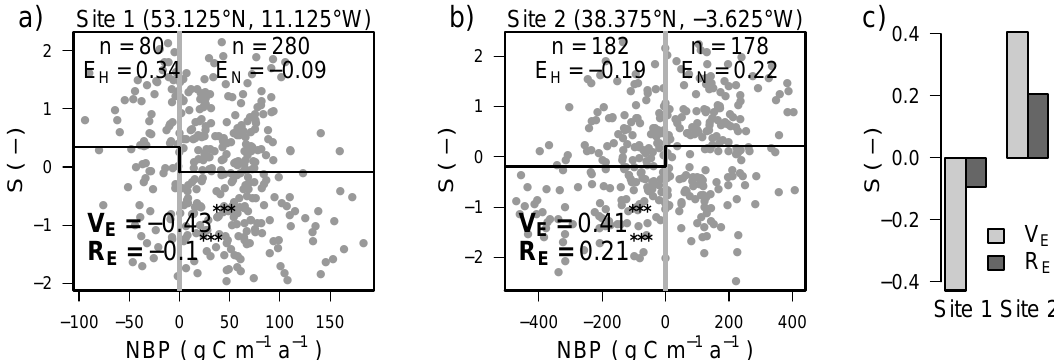
Figure 2. Scatterplots of sys variable NBP (gCm − 2 a − 1 ) against env variable SPEI (dimensionless) with monthly values from 1981 to 2010 for 2 sample grid cells in Europe: (a) northern Germany (53.125 ◦ N, 11.125 ◦ W) and (b) Spain (38.375 ◦ N, 3.625 ◦ E). Vertical lines denote the threshold value for the hazard and horizontal lines the expectation values for the respective env variable in the hazard ( E H ) and the non-hazard case ( E N ). Resulting expectation values, V E and the frequency of data points in both groups are given (dimensionless numbers). Significance level of the Welch t test between both groups is indicated for V E . (c) Calculated V E and R E values with negative sign for site 1 (vulnerable to wet conditions) and positive for site 2 (vulnerable to drought). Site 1 (53.125°N, 11.125°W)